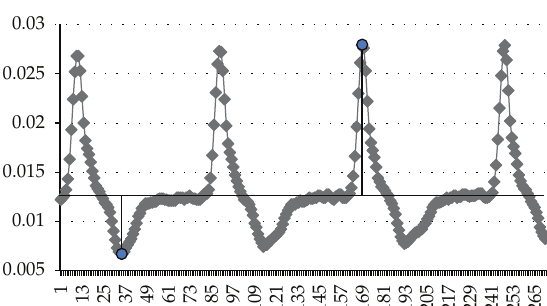
Figure 2: Four heartbeats detected in the segmented one-feature window from one